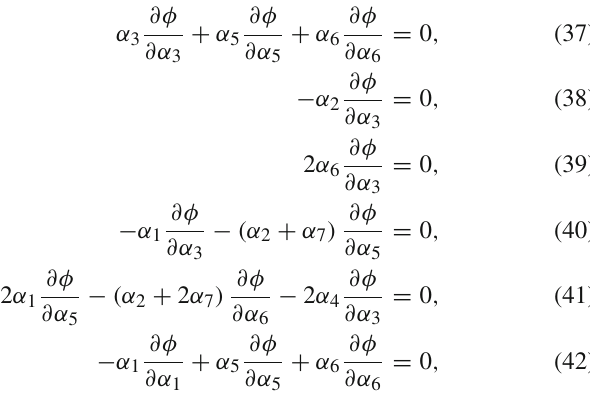
from where it follows φ (α i ) = φ (α 2 , α 4 , α 7 ) , that is, the